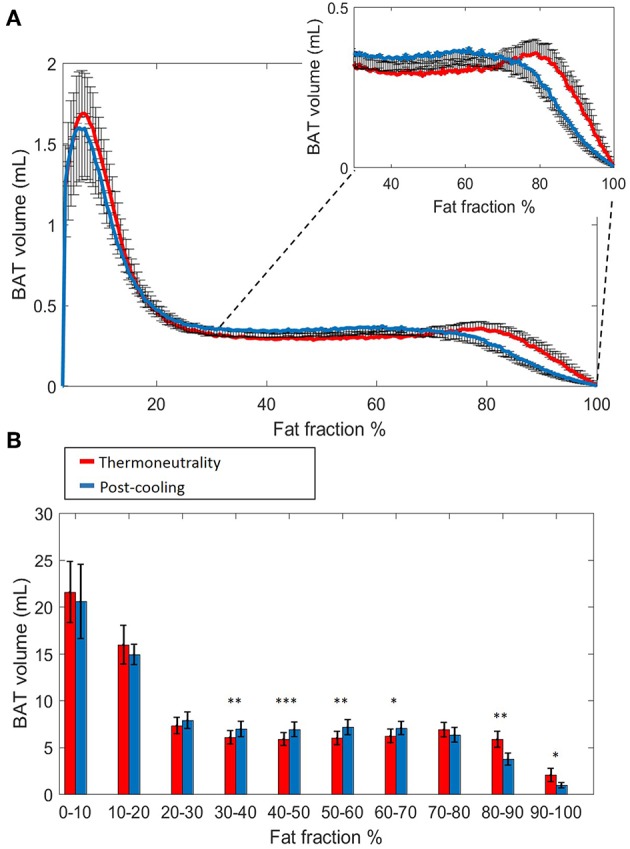
Estimated volumetric BAT analysis. Thermoneutral and post-cooling volume histograms as a function of fat fraction with bin size 0.5%: thermoneutral volumes are shown in red and post-cooling volumes in blue (A). Cold-induced volume changes plotted as a function of fat fractions (10% FF interval) (B). Data are represented as mean ± SEM for n = 9. In (B), a paired sample t-test was used to analyze the changes in volume after cold exposure. *p < 0.05, **p < 0.01, and ***p < 0.001.